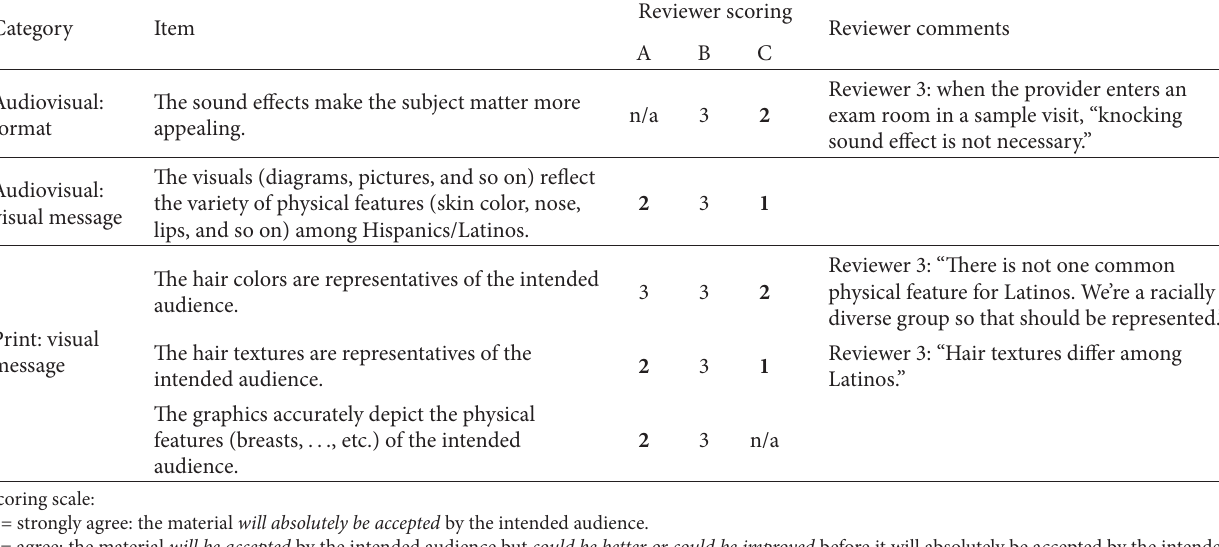
Table 5: Individual items with low scores (1 or 2) in the cultural sensitivity assessment tool